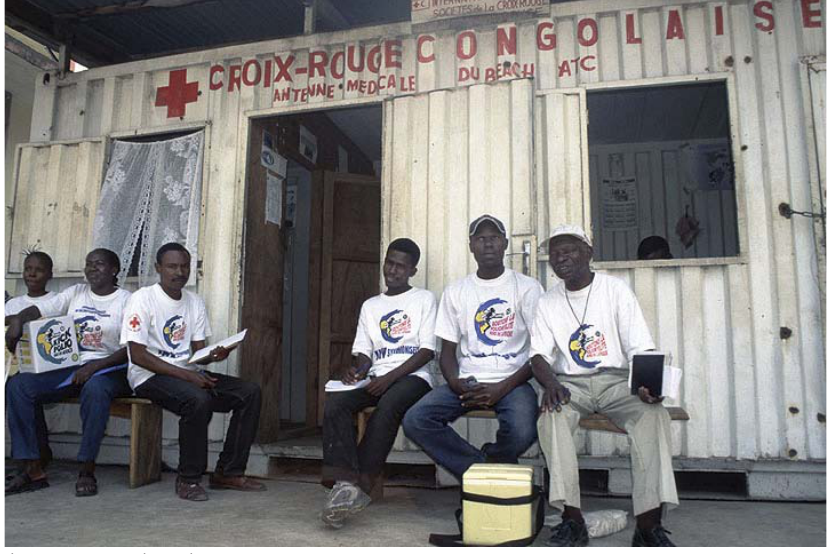
Figure 1. The Kick Polio Out of Africa Campaign This photo shows Red Cross volunteers, wearing “Kick Polio Out of Africa” T-shirts, waiting for boat transportation from Kinshasa, the Democratic Republic of the Congo, on a National Immunization Day. (Photo: Global Polio Eradication which accounted for 45% of polio cases